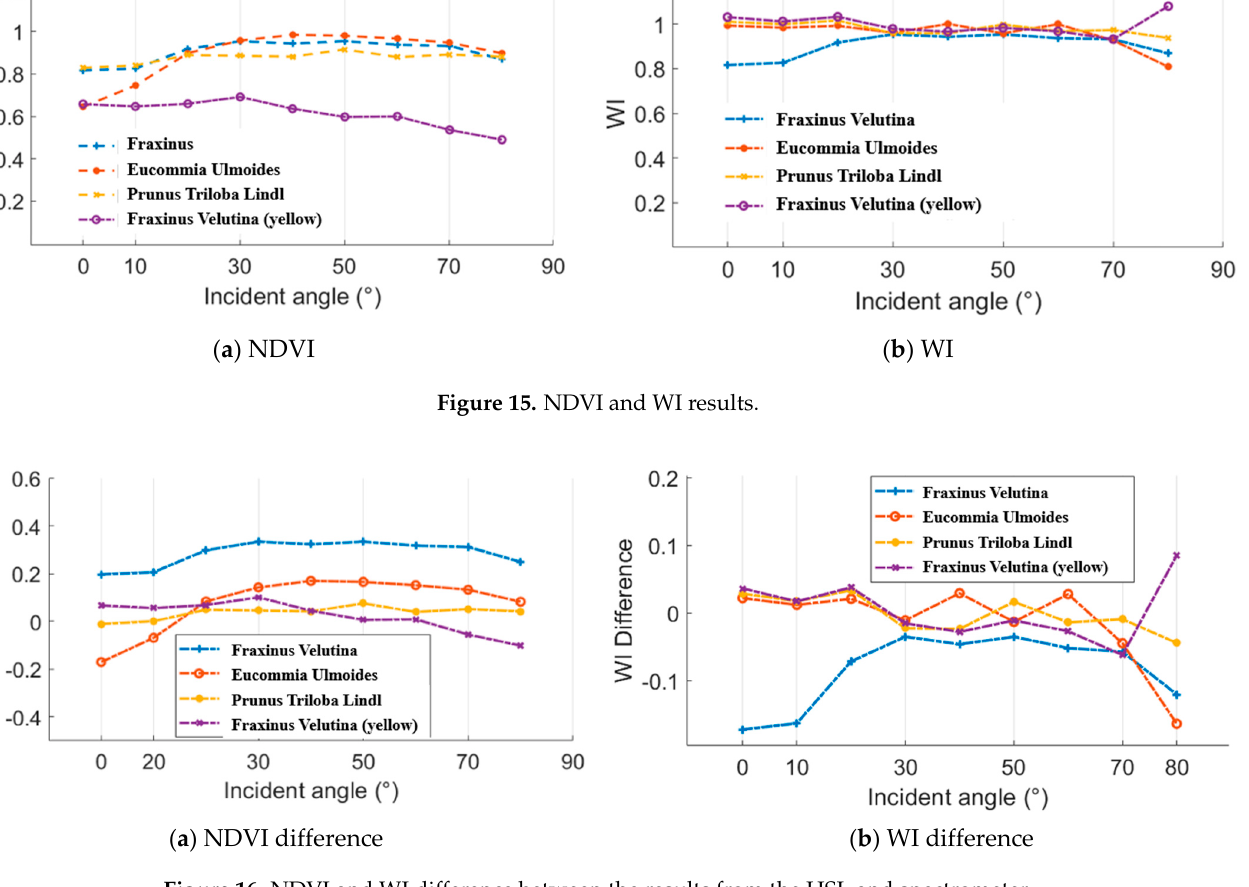
Figure 16. NDVI and WI difference between the results from the HSL and spectrometer.